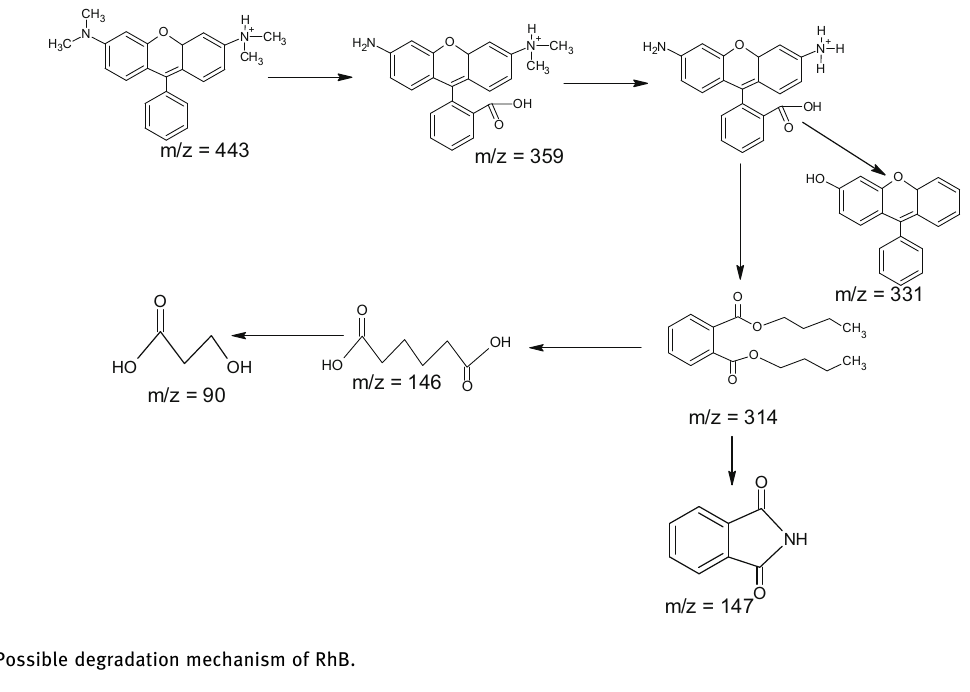
Figure 12: Possible degradation mechanism of RhB.